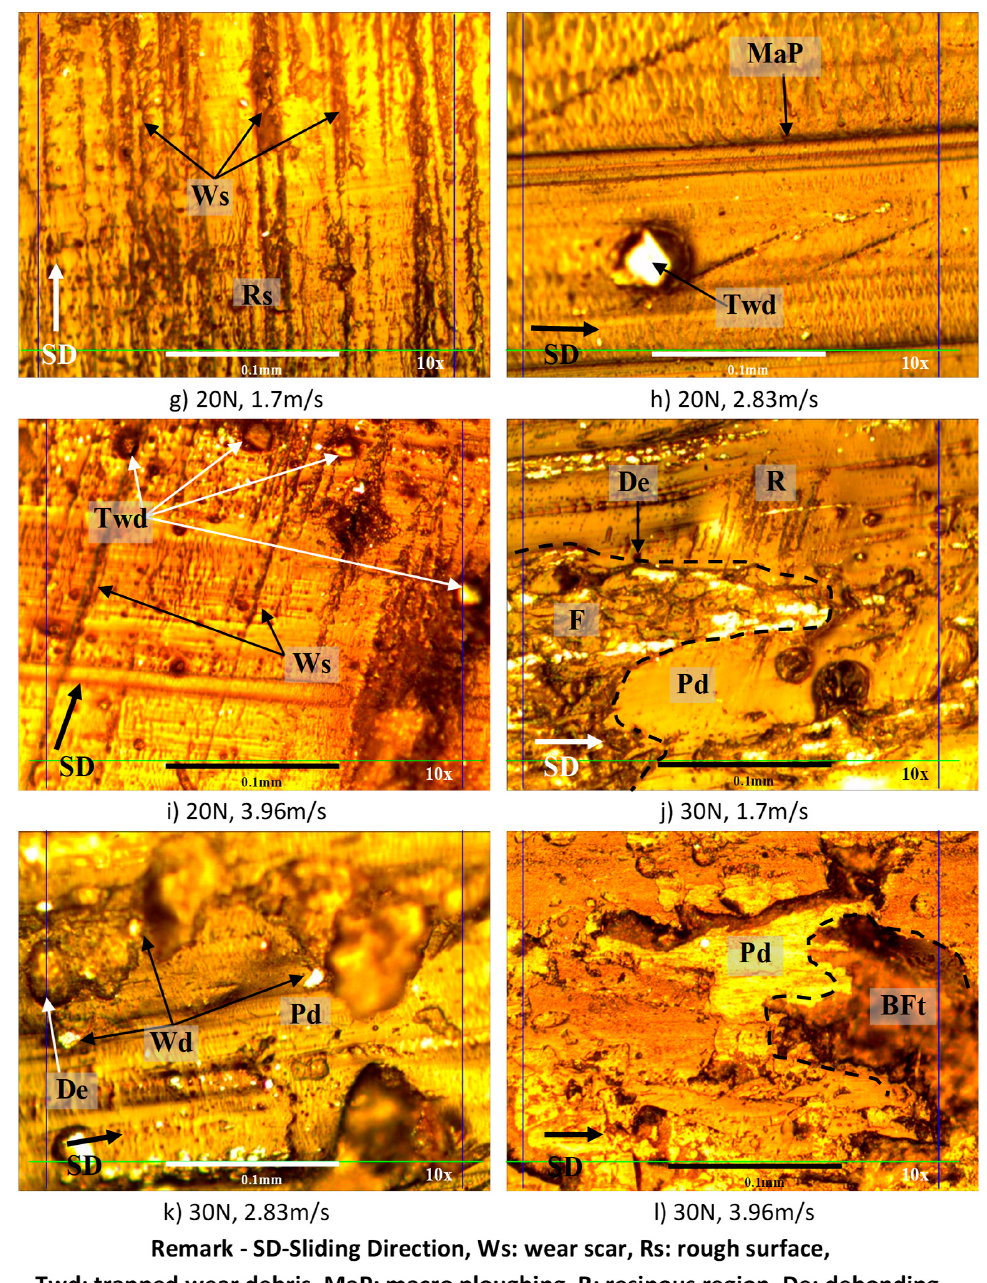
Figure 15. Photo micrographs of BAFRE composite tested in P-O under different applied normal loads at different counterface sliding velocities .